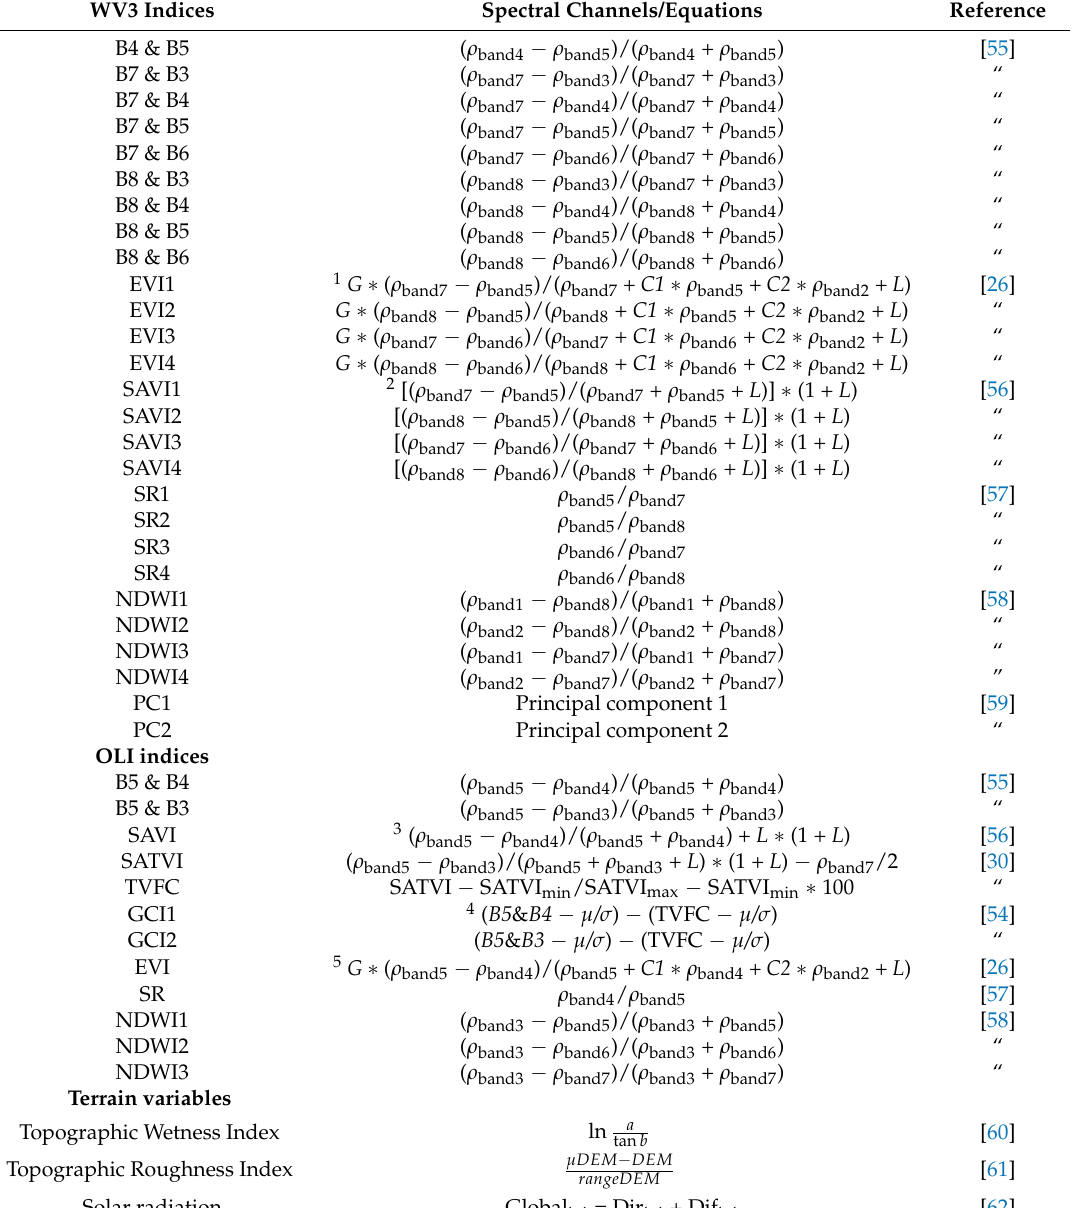
Table 1. Spectral indices and layers used in creating the biomass and vegetation cover models using peak-green (leaf-on) and censed (leaf-off) vegetation Worldview-3 and Operational Land Imager satellite image dates. References supplied provide the general computational form and background information for each index and topographic